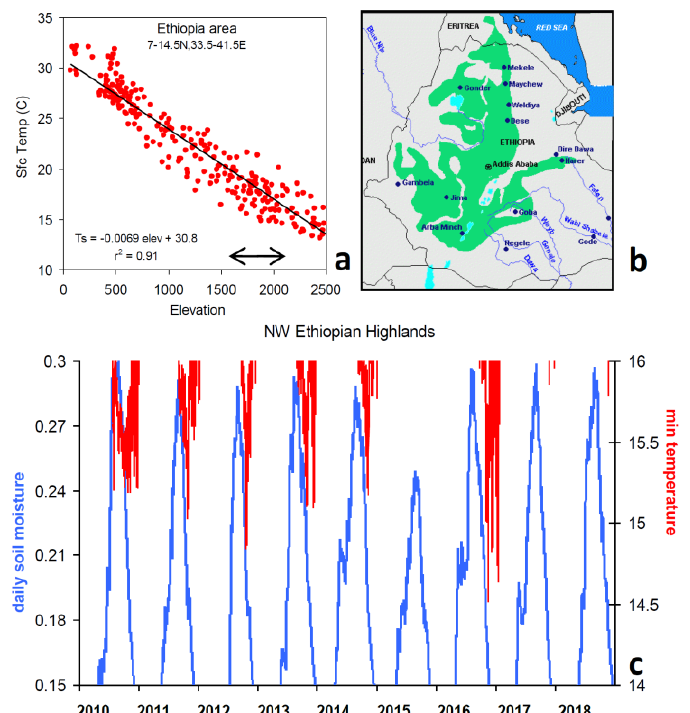
Figure A1. Mean annual cycle of NW Ethiopian highlands area-averaged ( a ) P and ( b ) E derived from SHF; comparing all 25 CMIP5 simulations with observation/reanalysis reference (bold green upper, bold red lower) 1981 – 2010. HadGEM2-ES rainfall (upper) is bold pink.